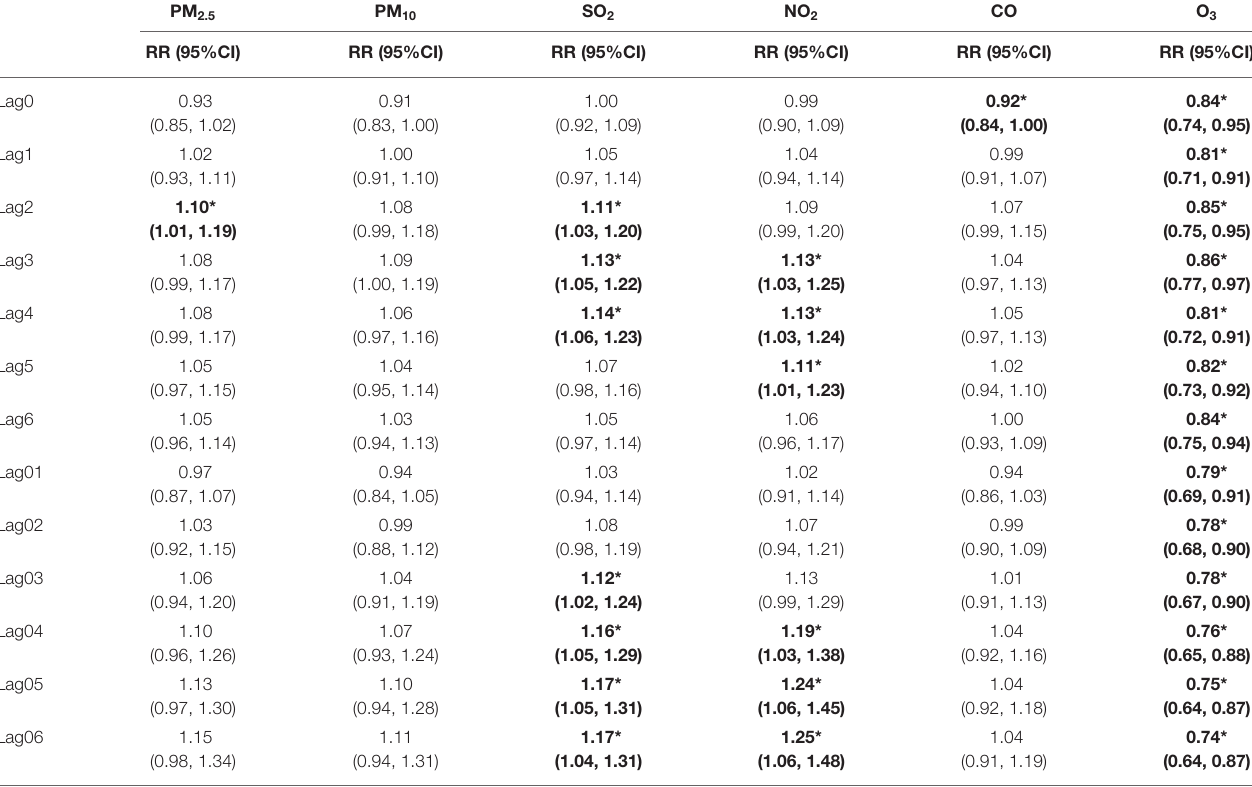
TABLE 4 | The relative risk (RR) of hospital admission for asthma in children per interquartile range (IQR) increase in different air pollutants in different lag days: single-pollutant model. PM 2.5